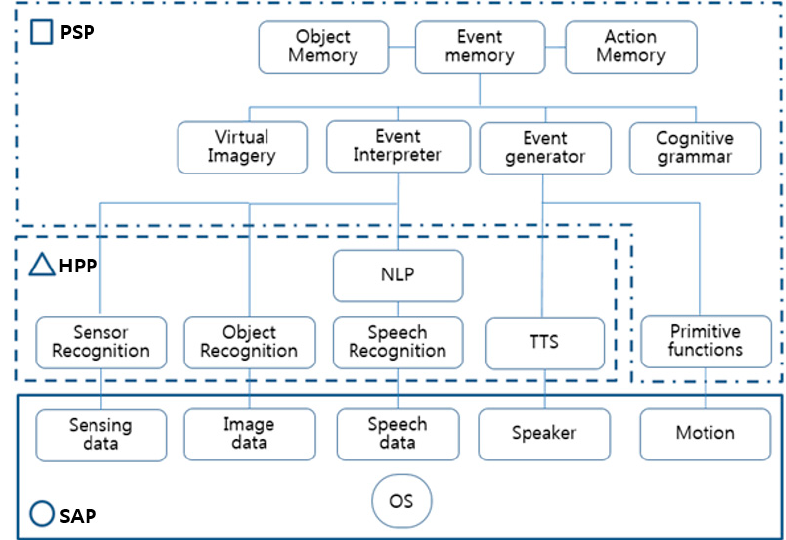
Figure 3. A schema of cognitive robot functionality. SAP: sensing and actuation part; PSP: privacy and security part; HPP: high performance part; NLP: natural language processing; OS: Operating System